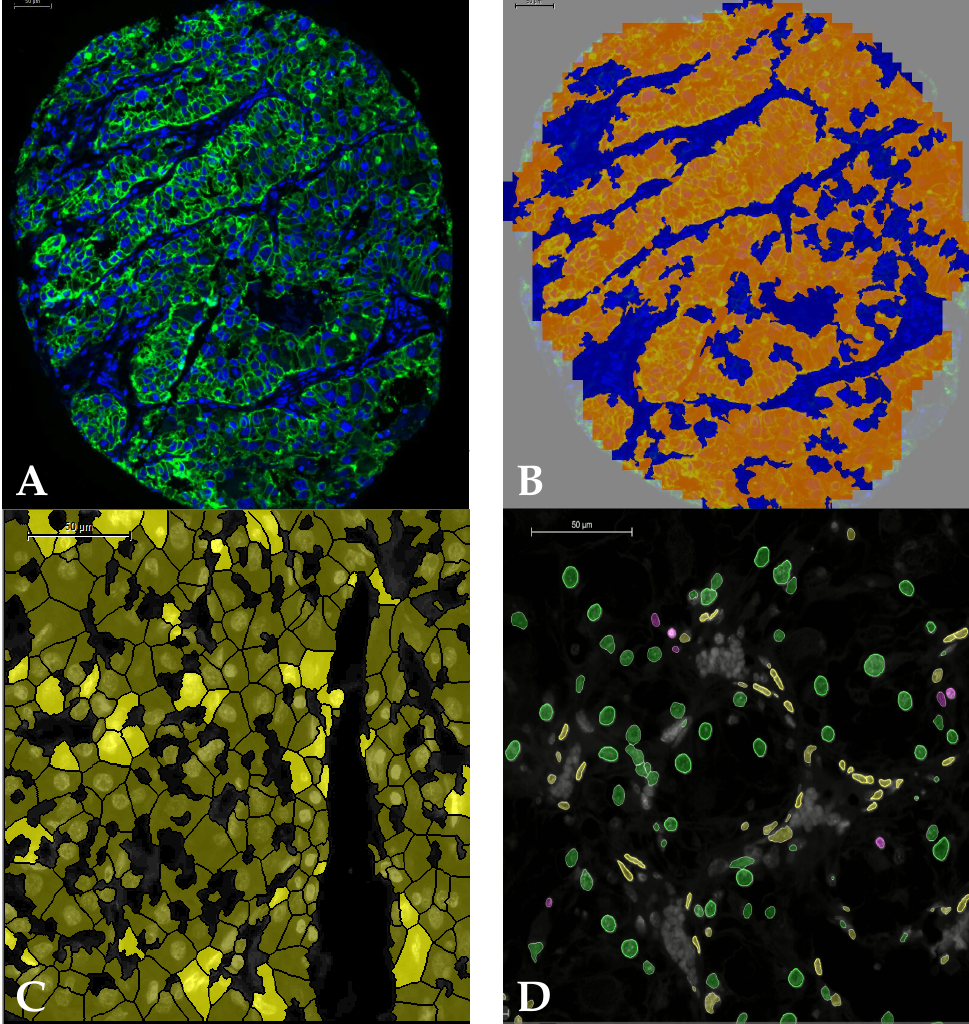
Figure 2. ( A ) TMA core showing nuclear (blue) and tumour (green) stain; ( B ) same TMA core after tumour (orange) stroma (blue) segmentation in Definiens ® Tissue Studio; ( C ) tumour cell simulation following tumour mask: positive tumour cells are shown in dark yellow, while tumour cells positive for PD-L1 are shown in bright yellow; ( D ) nuclear phenotyping only based on nuclear morphology using Halo ® AI showing tumour nuclei (green), immune nuclei (purple), and fibroblast nuclei (yellow). Red blood cells (gray) were excluded from the